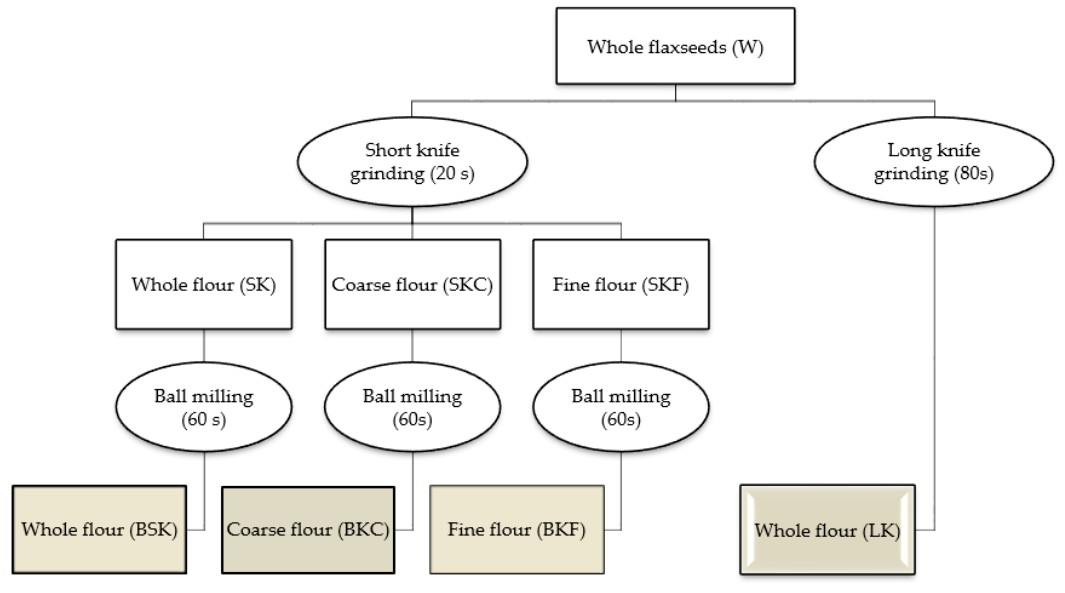
Figure 1. Experimental design of obtaining samples.